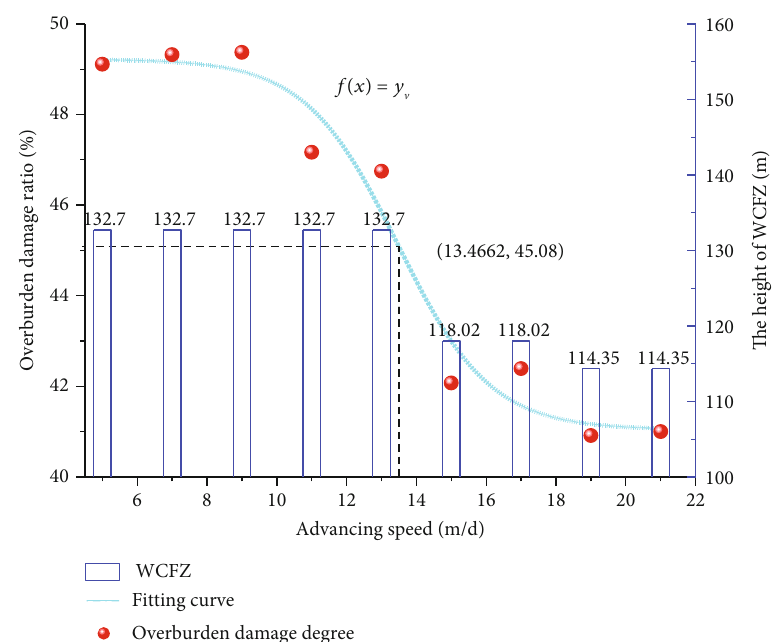
Figure 10: Overburden damage degree and the height of WCFZ versus advancing speed.